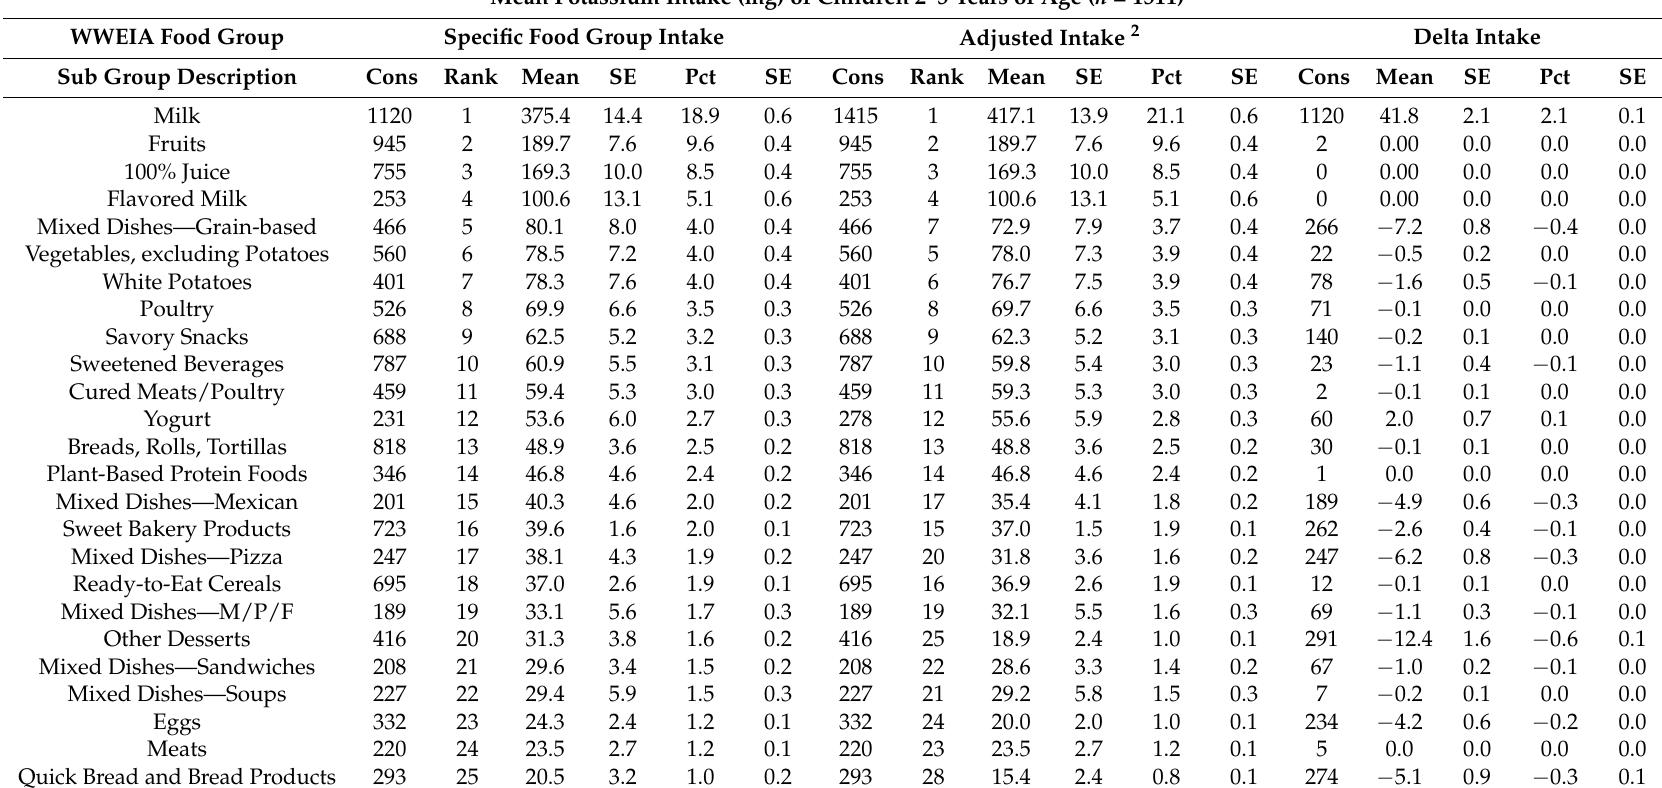
Table 5. Food/food group sources 1 of mean potassium (mg) intake among US children aged 2–18 years ( N = 5876): National Health and Nutrition Examination Survey